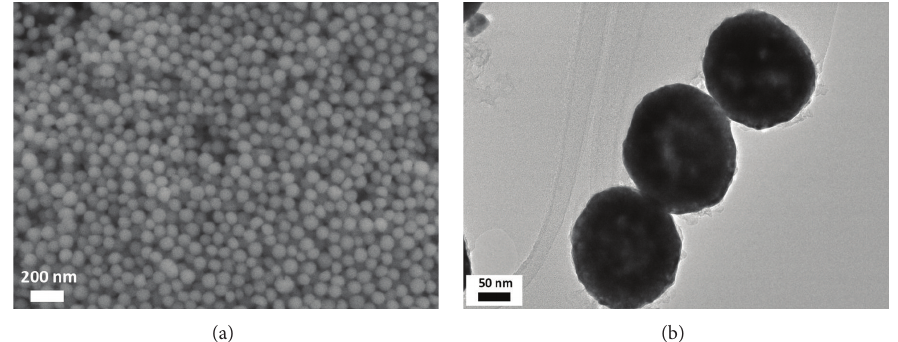
Figure 1: The SEM (a) and TEM (b) images of the PHAuNPs were used to determine the sizes of the particles. It was found that the particle sizes were consistent at 150 nm ± 10%.